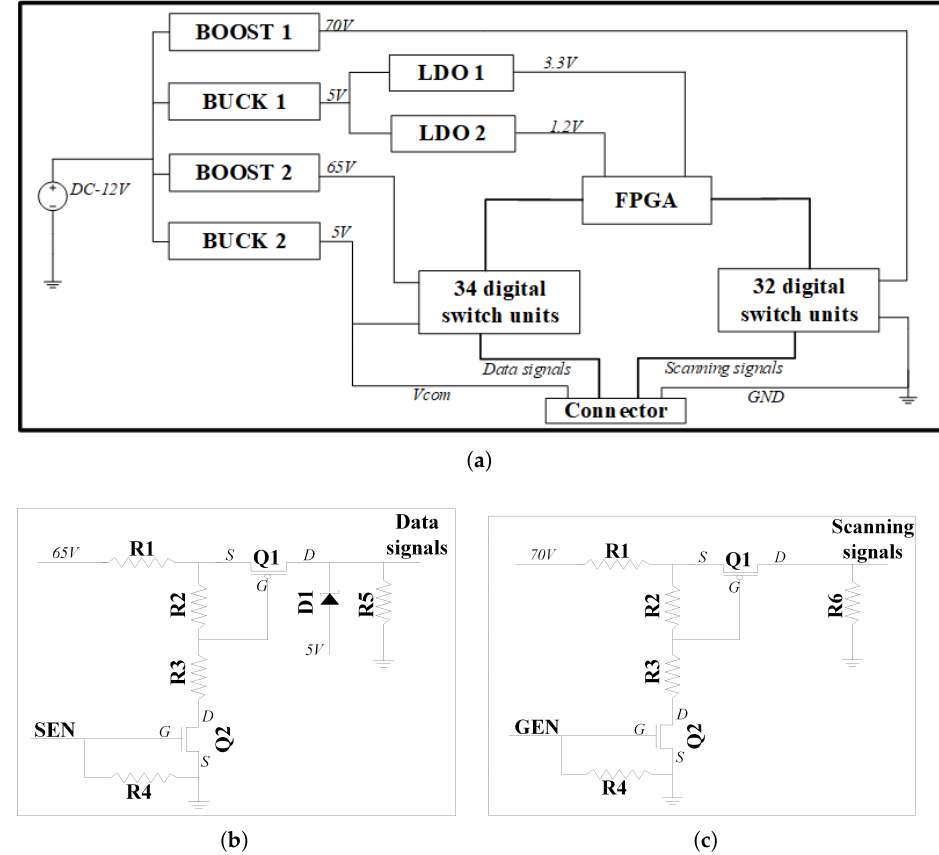
Figure 7. ( a ) Schematic diagram of customized designed PCB controlling circuit; ( b,c ) Schematic circuit diagram of switch unit 1 and